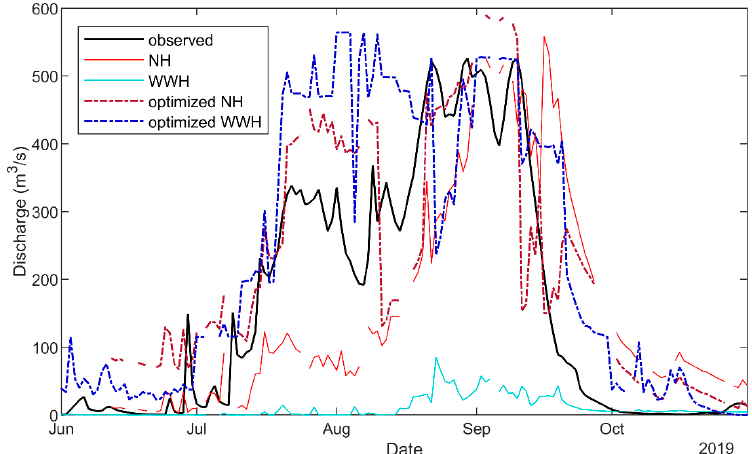
Figure 7. Hydrograph of original and optimized 5-day NH and WWH in Garbey Kourou for the